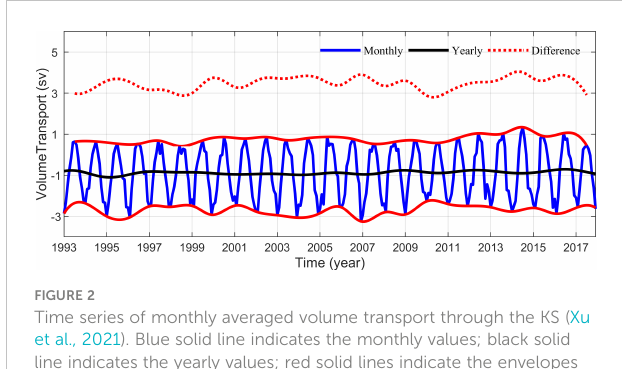
FIGURE 2 Time series of monthly averaged volume transport through the KS (Xu et al., 2021). Blue solid line indicates the monthly values; black solid line indicates the yearly values; red solid lines indicate the envelopes of the blue line; and red dotted line indicates the difference between red solid